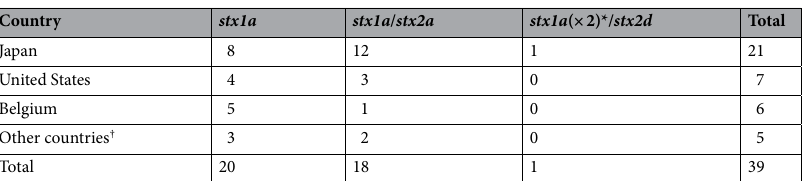
Table 1. The stx genotypes of O26:H11 strains analysed in this study. *2 copies of stx1a genes. †